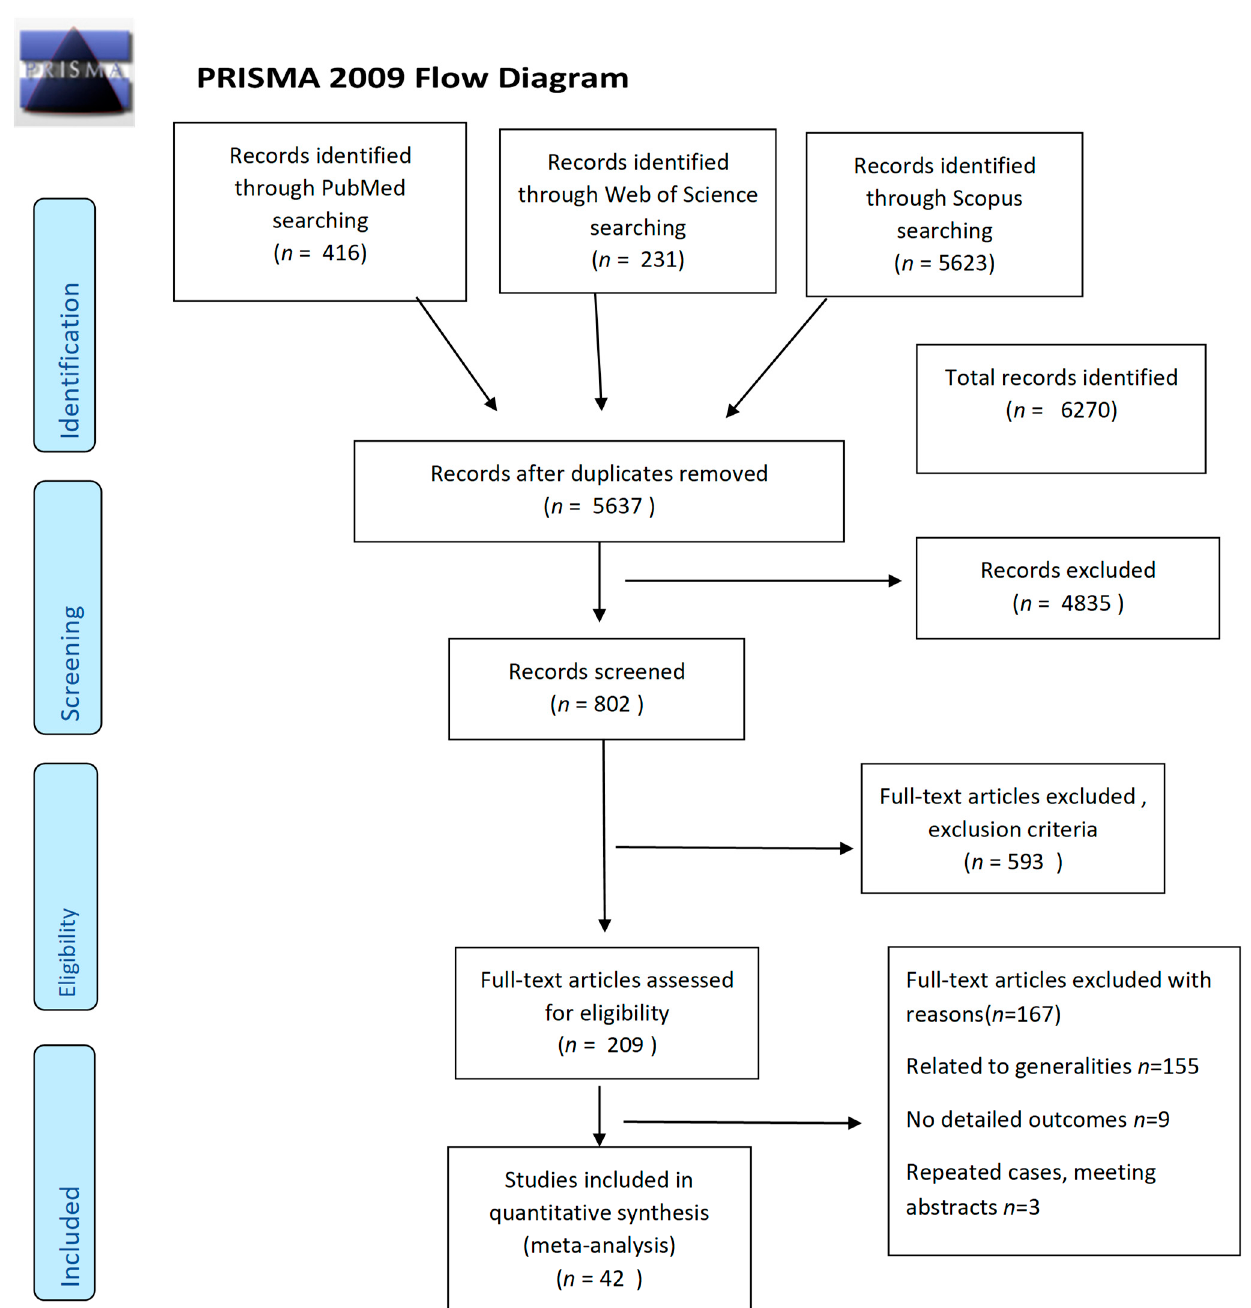
Figure 1. PRISMA flowchart of the literature review and selection process for clinical presentation and features of severe anaphylaxis in pregnancy to determine outcomes.